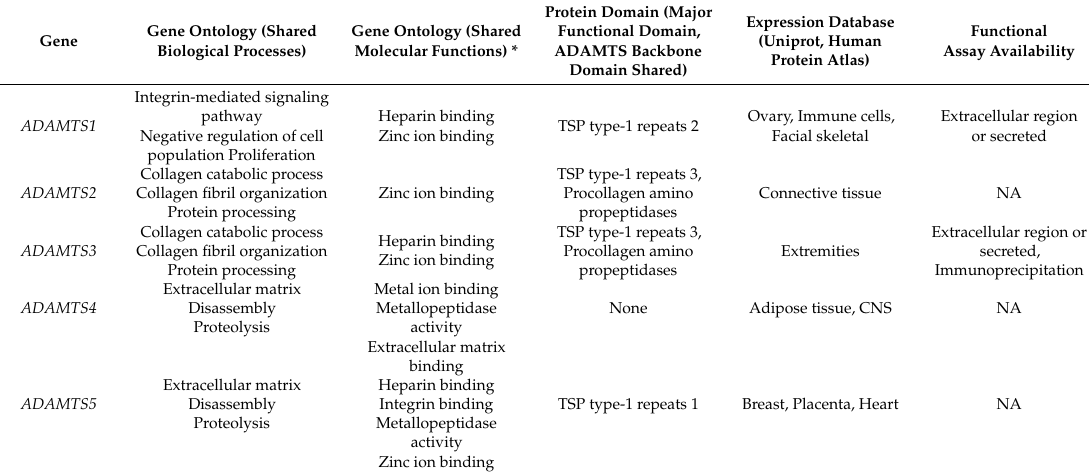
Table 2. Evidence-based evaluation of the clinical validity of ADAMTS family genes in gene– disease